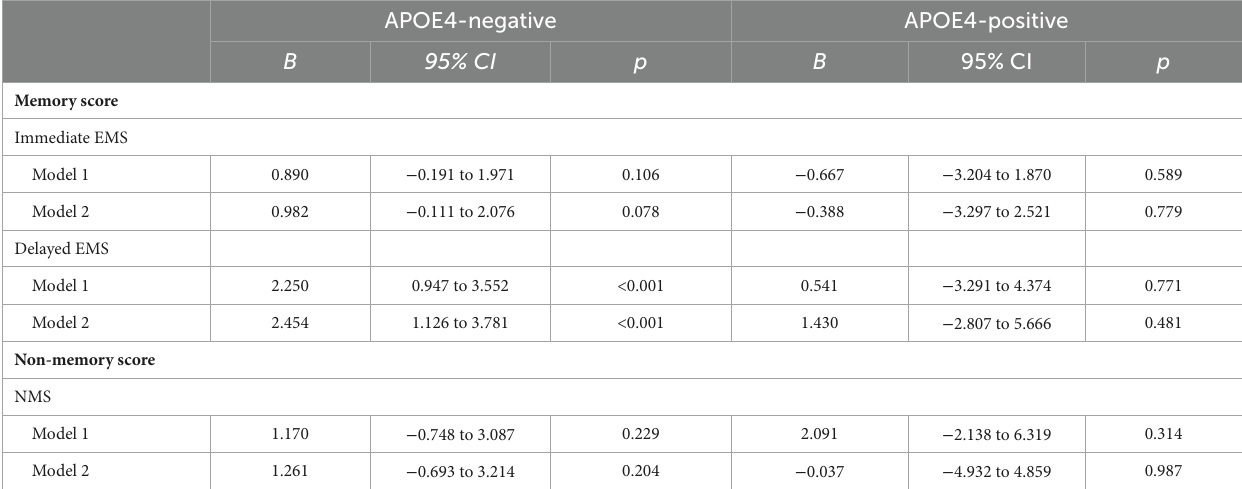
TABLE 4 Results of the multiple linear regression analyses of the association between ginseng intake status and cognition according to APOE4